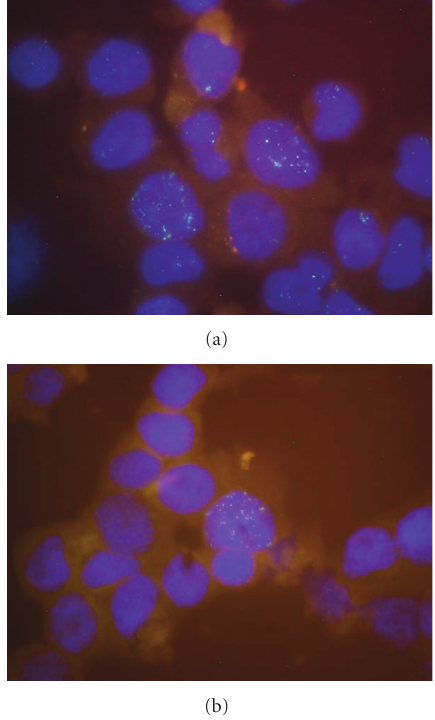
Figure 4: Interphase FISH assay for the demonstration of EBV in cell lines. Hybridization was performed with EBV cosmid cM- Sal I-A labeled with Spectrum Green by nick-translation. Nuclei were stained with DAPI. (a) Nuclei of cell line BONNA-12 contains heterogeneous numbers of EBV copies. (b) Cell line DOHH-2 displays only few cells contaminated with